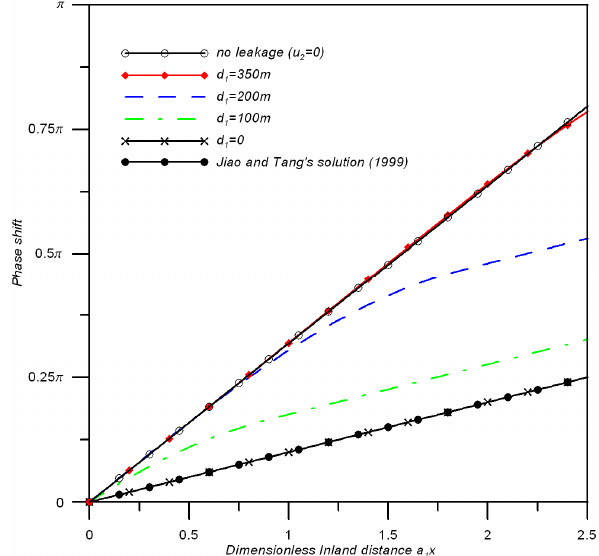
Figure 5. The curves of phase shift of the head fluctuation versus dimensionless inland distance for u 1 = 0, u 2 = 5, a 1 = a 2 = 1 × 10 − 2 m − 1 , and various values of d 1 .